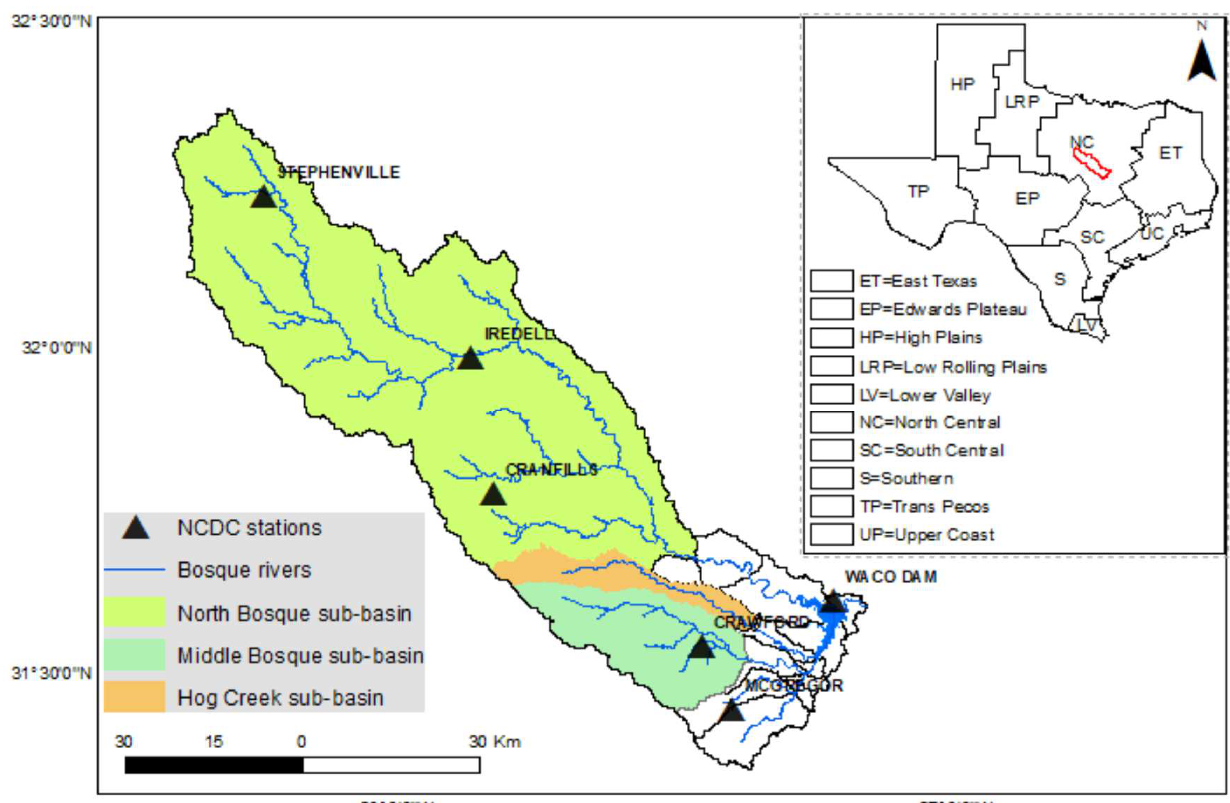
Figure 1. Bosque watershed and location of climatic and hydrologic stations. The NCDC climatic stations (16) located in and around the Bosque watershed were used in this study. The streamflow gauges (blue triangle) were used to calibrate and validate the SWAT model.